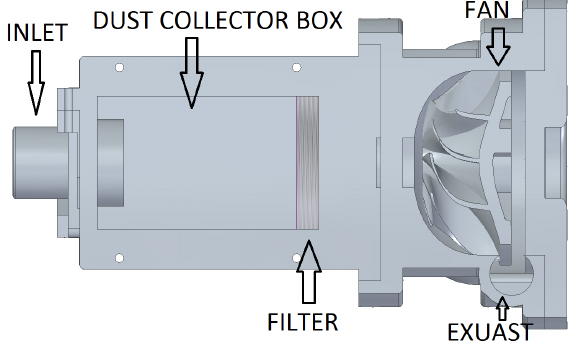
Figure 2. Cut sectional view of the vacuum system.